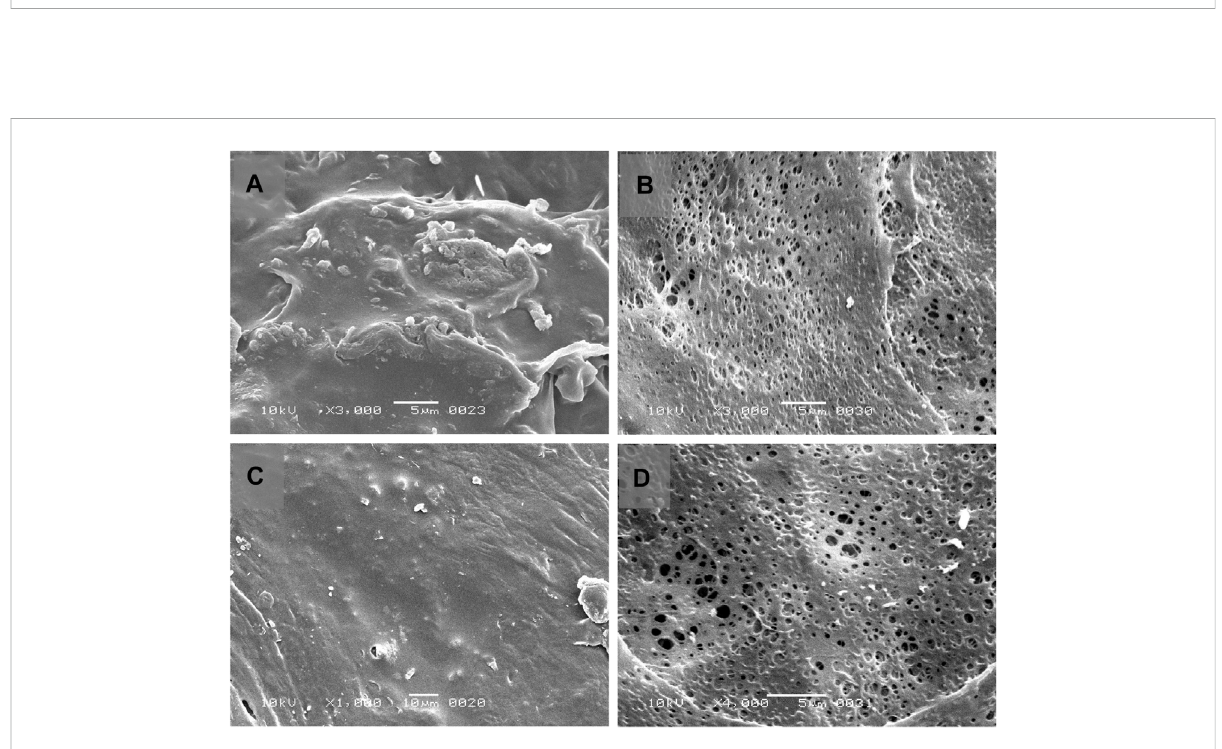
FIGURE 6 Scanning electron micrograph (SEM) of Opadry ® CA coating on core osmotic tablet formulations before dissolution (A) [F3] and (C) [F4] and after dissolution experiments (B) [F3] and (D) [F4].